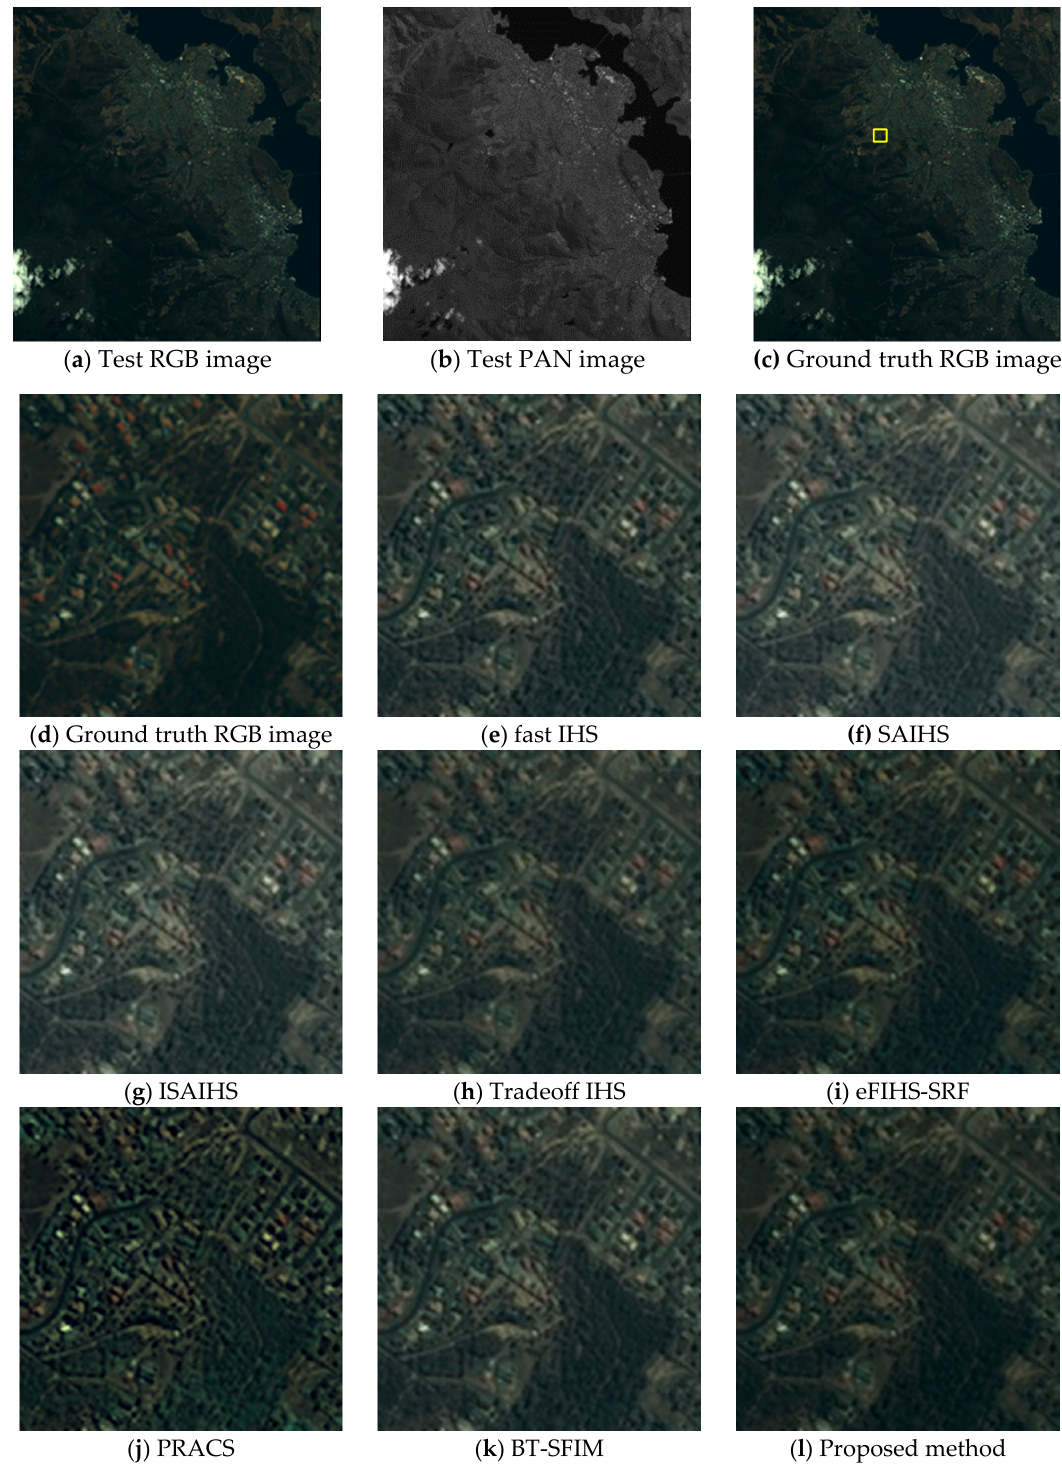
Figure 6. Visual comparison of test Tasmania images: ( a ) Test RGB image; ( b ) Test PAN image; ( c ) Ground truth RGB image (i.e., Original RGB image); ( d ) Ground truth RGB image of the yellow box area in (c); ( e–l ) PS images generated by various methods corresponding to the area of (d).